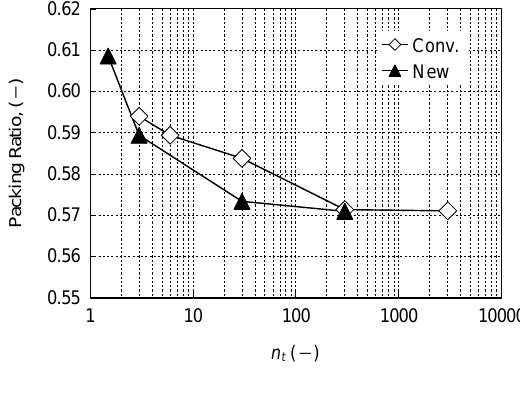
Result of packing